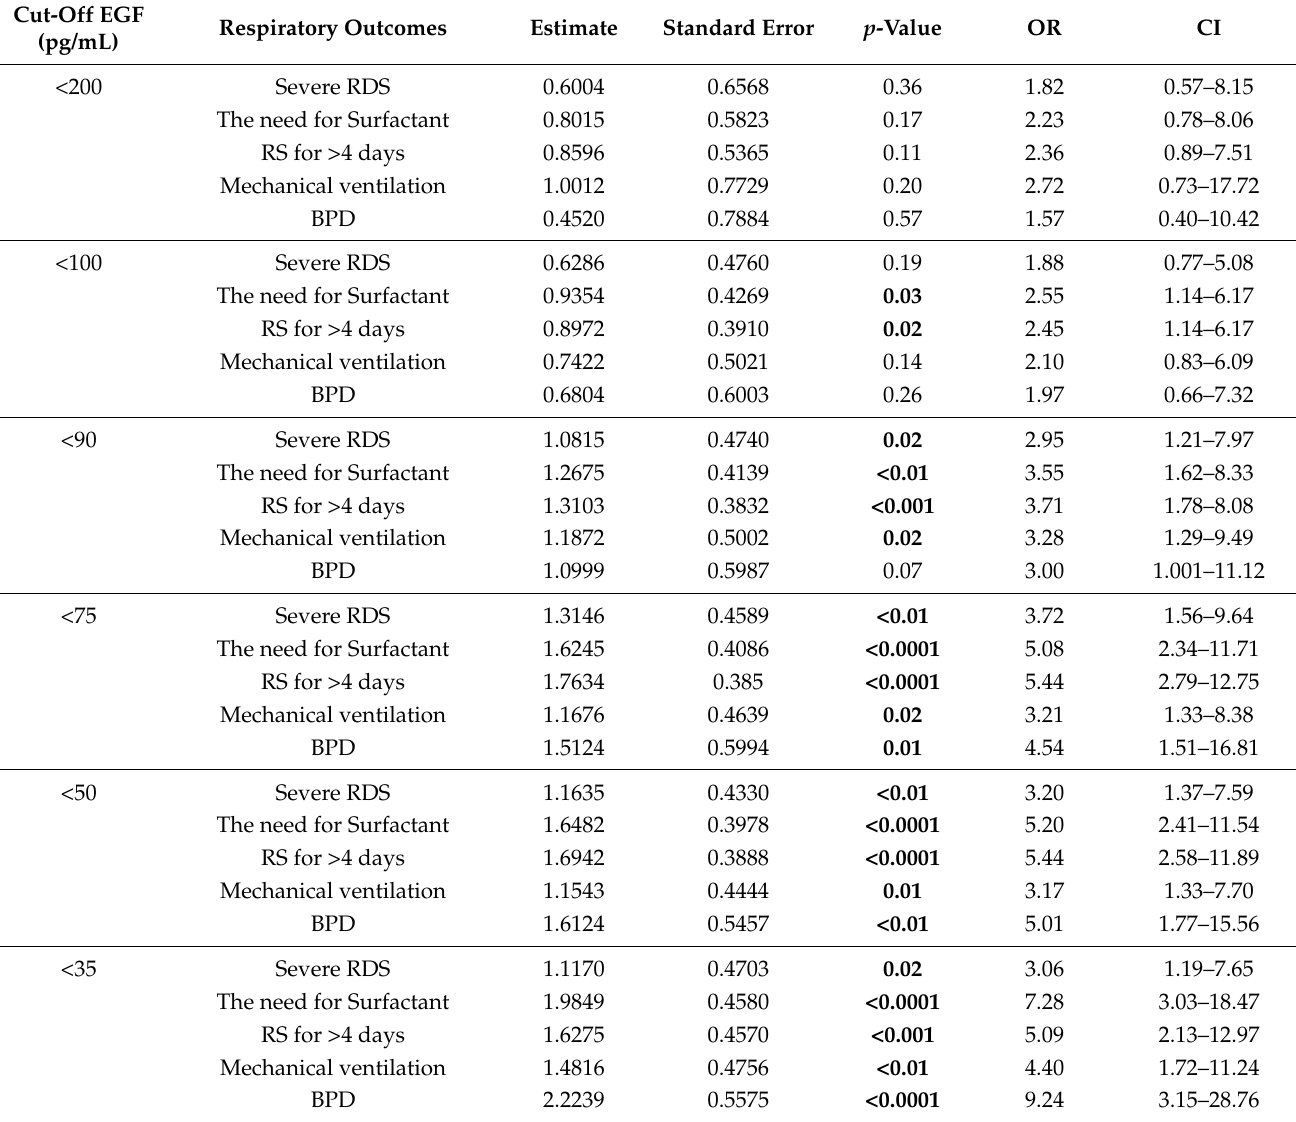
Table 1. The regression analysis for severe respiratory outcomes with various cut-off values of EGF: respiratory outcomes as the outcome variable, different cut-off values of EGF as the input variable. Significant results are bolded. OR—odds ratio, CI—95% Confidence Interval; RDS—respiratory distress syndrome; RS—respiratory support; BPD—bronchopulmonary